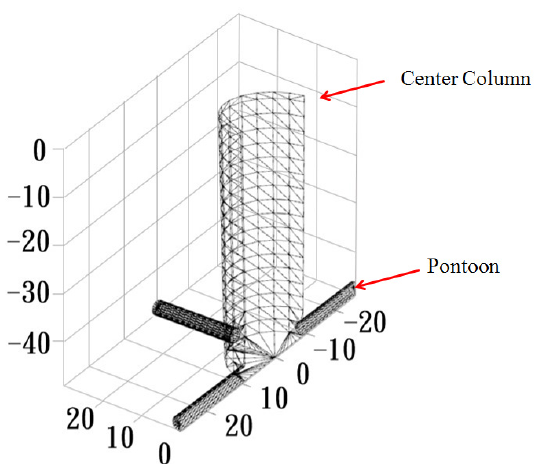
Appl. Sci. 2019 , 9 FOR PEER REVIEW Figure 11. The mesh discretization of the MIT/NREL TLP with triangular panels. (Unit: m.) Table 3. Panel properties of the MIT/NREL TLP wetted hull.